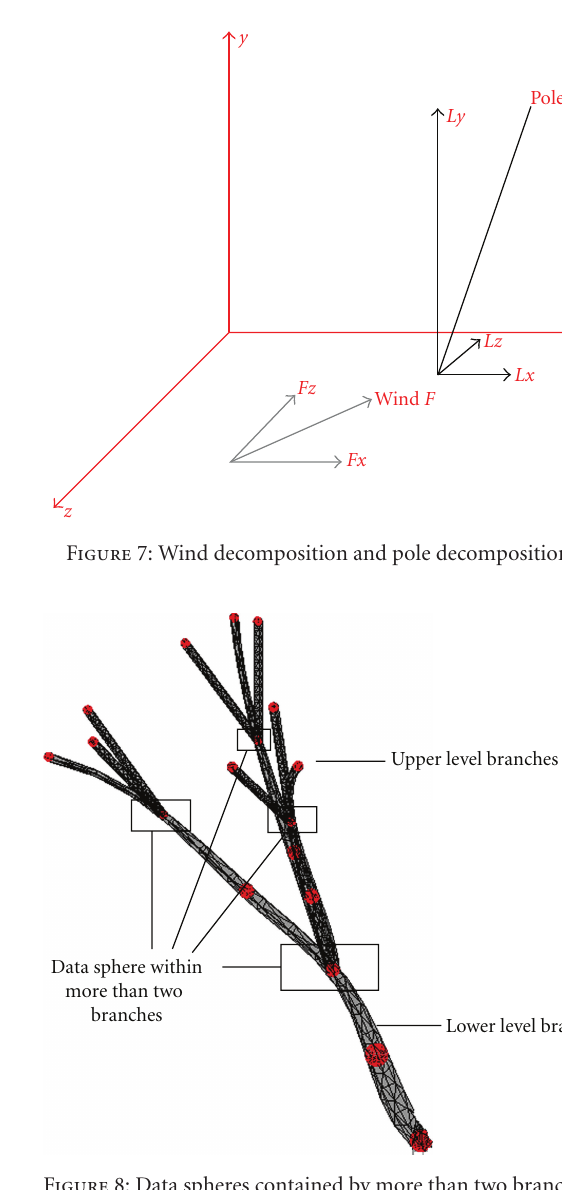
Figure 8: Data spheres contained by more than two